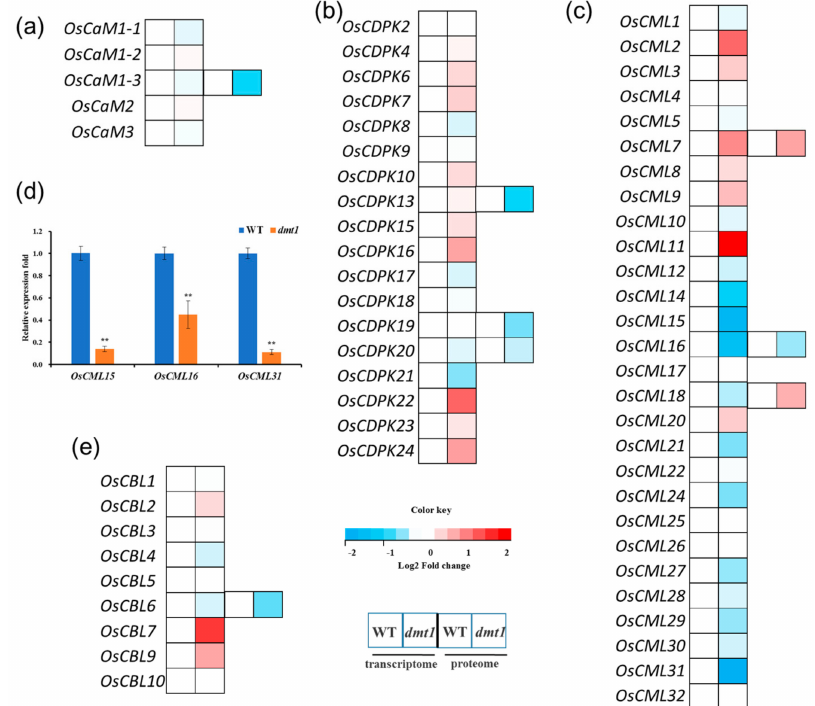
Figure 5. Expression patterns of Ca sensor genes and proteins between the dmt1 mutant and the WT. ( a–c ) Expression patterns of CaMs ( a ), CDPKs ( b ), and CMLs ( c ) in the transcriptome and proteome. In the heatmap for each gene, the first two cells represented the WT and the dmt1 mutant (left to right) within the transcriptome, and the third and fourth cells represented the WT and the dmt1 mutant (left to right) within the proteome. ( d ) The expression of OsCML15, OsCML16, and OsCML31 was validated by qRT-PCR; ACTIN1 was used for a control, ** p < 0.01, Student’s t -test; ( e ) Expression patterns of CBLs in the transcriptome and proteome. In the heatmap for each gene, the first two cells represented the WT and the dmt1 mutant (left to right) within the transcriptome, and the third and fourth cells represented the WT and the dmt1 mutant (left to right) within the